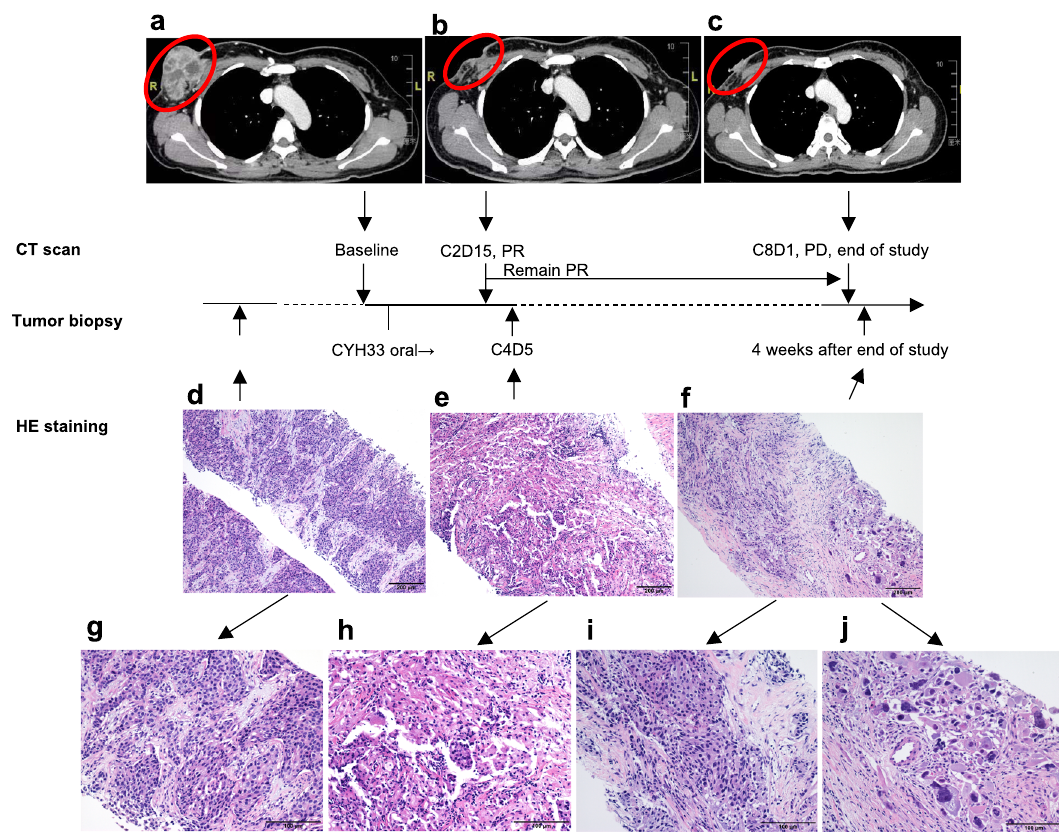
Fig.3|RepresentativeCTimagesandHEstainedbiopsysectionsfromapatient inthe40mgCYH33treatmentgroupwithadvancedbreastcancer(LuminalB, HER2-, PIK3CA E545K mutation) who achieved a rapid and robust treatment response. a Baseline CT image (September 18, 2019): a mass (red circle) was detectedintheupperouterquadrantoftherightbreastonenhancedCT. b Cycle2 Day 15 CT image (November 25, 2019): the mass (red circle) had reduced on enhanced CT compared with baseline. c End of study visit CT image (April